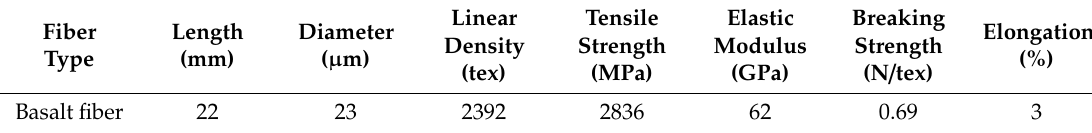
Table 2. Properties of basalt fibers.